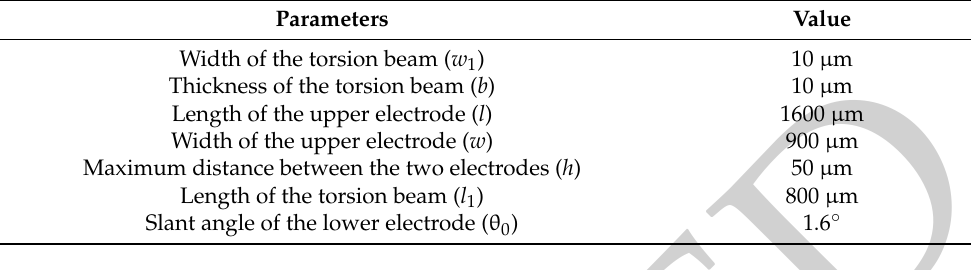
Figure 1. Schematic diagram of the photovoltaic-electrostatic hybrid actuator with a slant lower electrode. ( a ) The structure parameters of the actuator. ( b ) Force condition of the actuator. Table 1. The structure parameters of the photovoltaic-electrostatic hybrid actuator. Parameters Value Width of the torsion beam ( w 1 ) 10 μm Thickness of the torsion beam ( b ) 10 μm Length of the upper electrode ( l ) 1600 μm Width of the upper electrode ( w ) 900 μm Maximum distance between the two electrodes ( h ) 50 μm Length of the torsion beam ( l 1 ) 800 μm Slant angle of the lower electrode (θ 0 ) 1.6 °